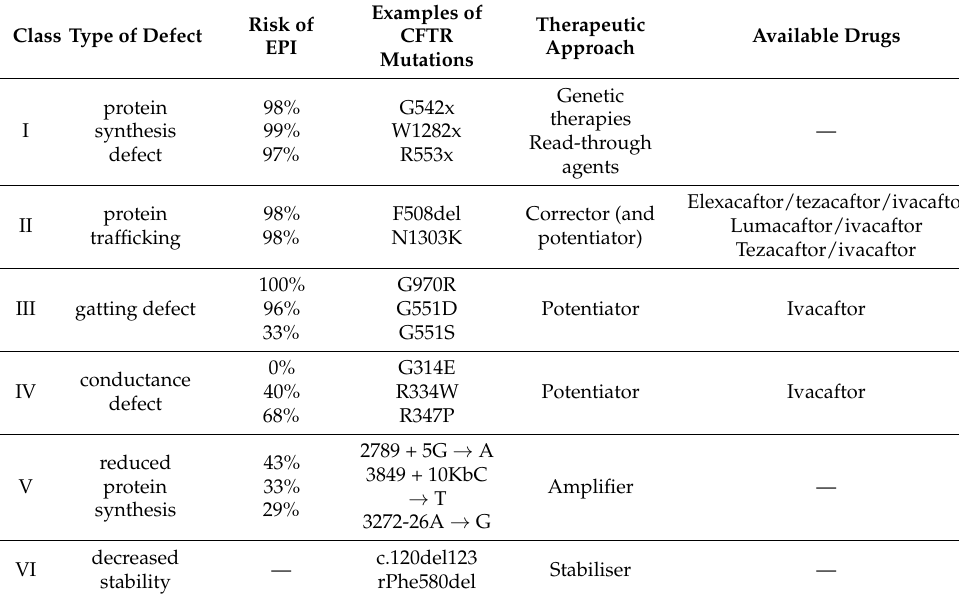
Table 2. Classes of CFTR mutations, risk of EPI and therapeutic approach (adapted from CFTR2— Clinical and Functional Translational of CFTR and McKay et al.)